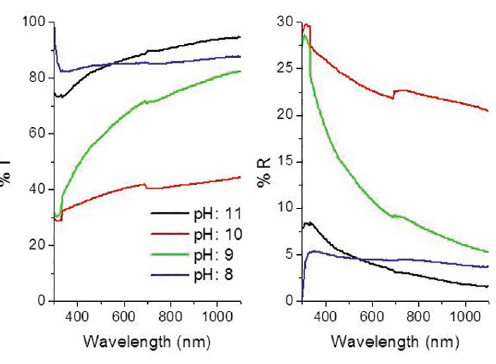
films deposited at various pH levels: (a) pH 11, (b) pH 10, (c) pH 9, (d) pH 8 4